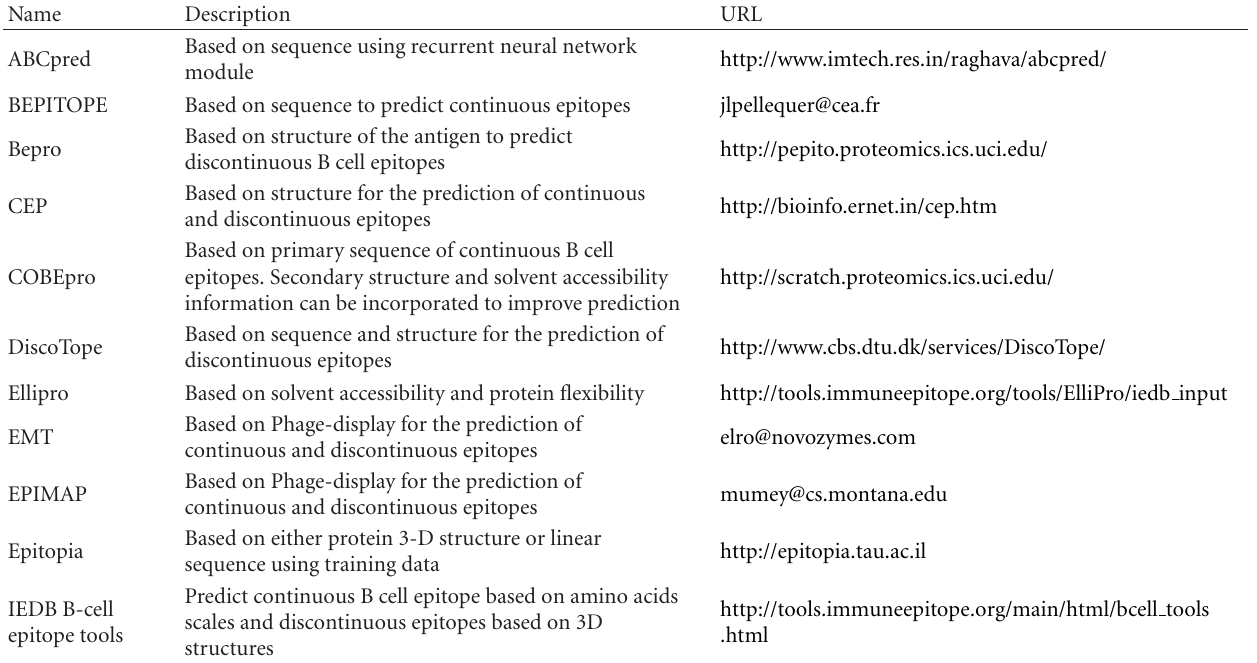
Table 1: B-cell epitope prediction tools. This table, adapted from Table 1 [164] summarizes available websites for B-cell epitope prediction. The prediction mechanisms employed, URLs, or authors’ email addresses are included. Detailed descriptions and references are included in the paper.